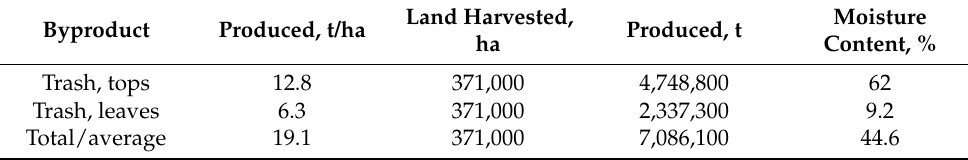
Table 7. Amount of tops and leaves produced in